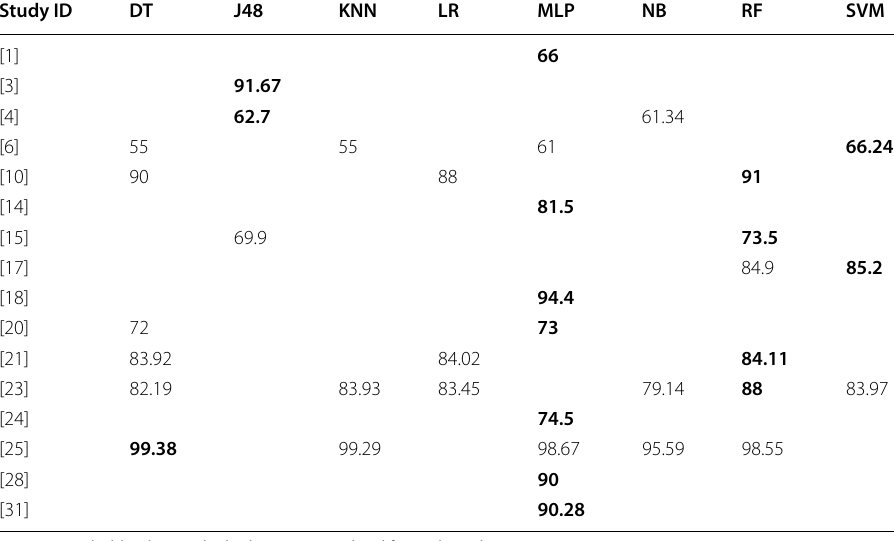
Note . Text in bold indicates the highest accuracy level for each